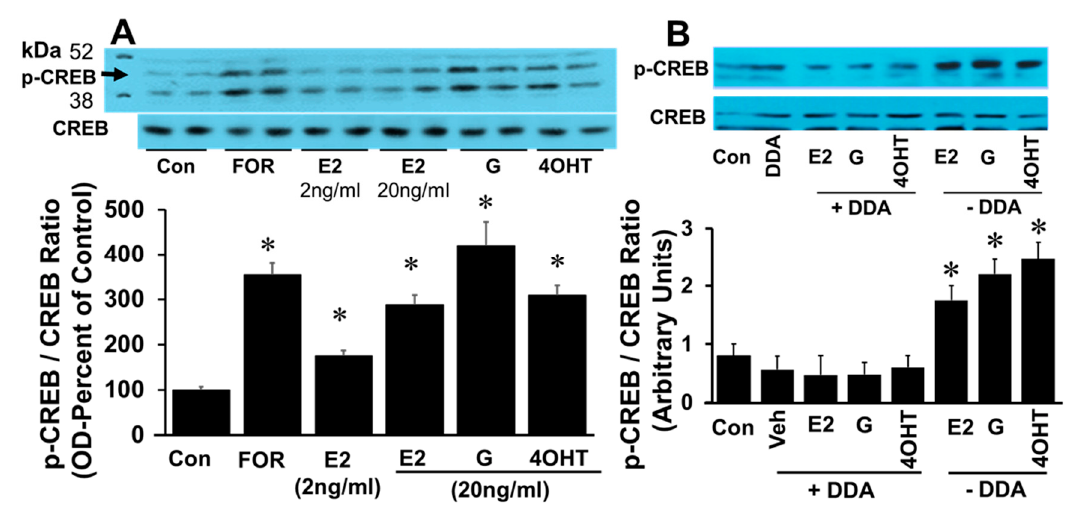
Figure 7. Panel ( A ) depicts a representative western blot and corresponding bar graph showing the changes in CREB phosphorylation in FT cells treated for 30 min with either forskolin (FOR; 50 μ M), 17 β -estradiol (E2; 2, 20 ng/mL), genistein (G; 20 ng/mL) or 4-OH-TCB (20 ng/mL). Panel ( B ) shows a representative western blot and corresponding bar graph depicting the modulatory effects of adenylyl cyclase inhibitor 2 ′ ,5 ′ -dideoxyadenosine (DDA; 10 μ M) on 17 β -estradiol (E2; 20 ng/mL), genistein (G; 20 ng/mL) and 4OH-TCB (4OHT; 20 ng/mL) induced CREB phosphorylation in FT cells. Data represent (mean ± SEM) from separate experiments ( n = 3). Results for phosphorylated CREB were normalized, with non-phosphorylated CREB and change in OD expressed as arbitrary units or percent of control. * p < 0.05 vs. untreated control, Con).